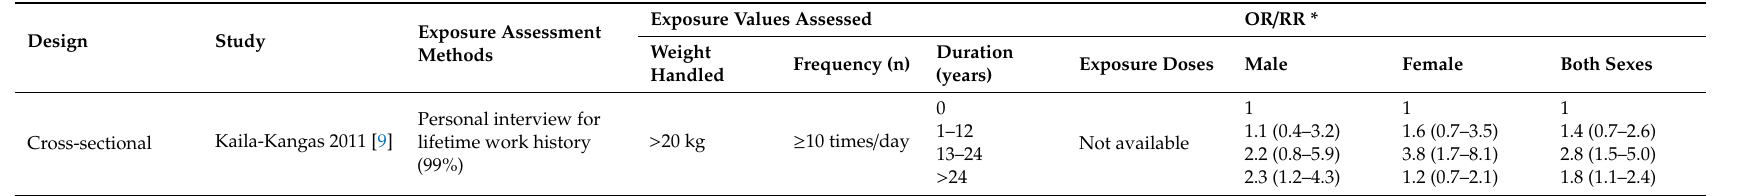
Table 4. Exposure data, exposure assessment methods and e ff ect estimates of studies stating a dose–response relationship.